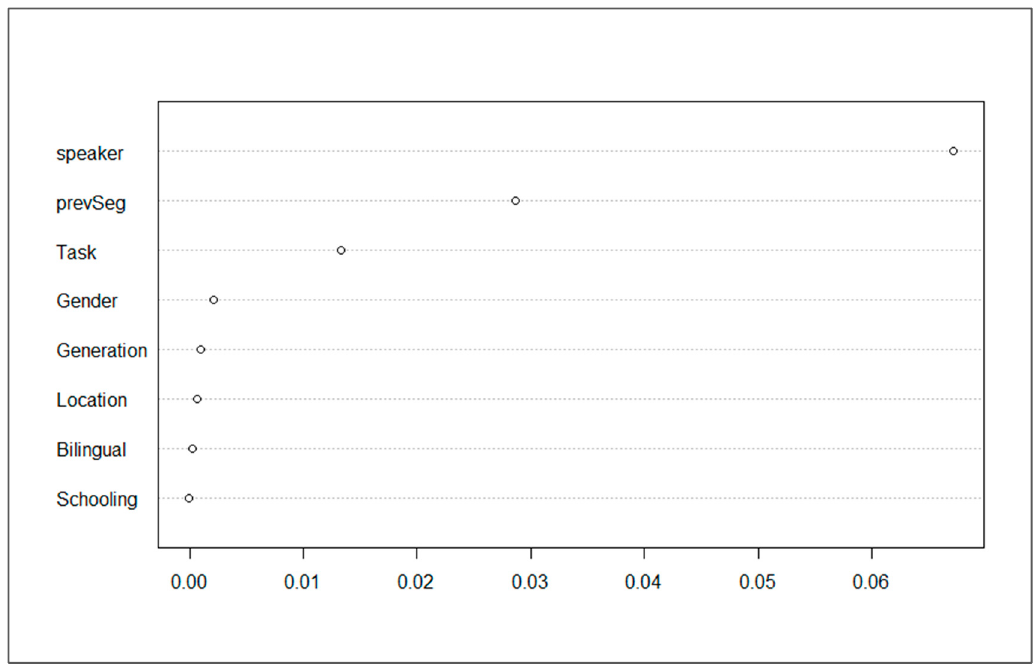
Figure 6. Conditional permutation variable importance for the random forest with all predictors of rhotic assibilation.